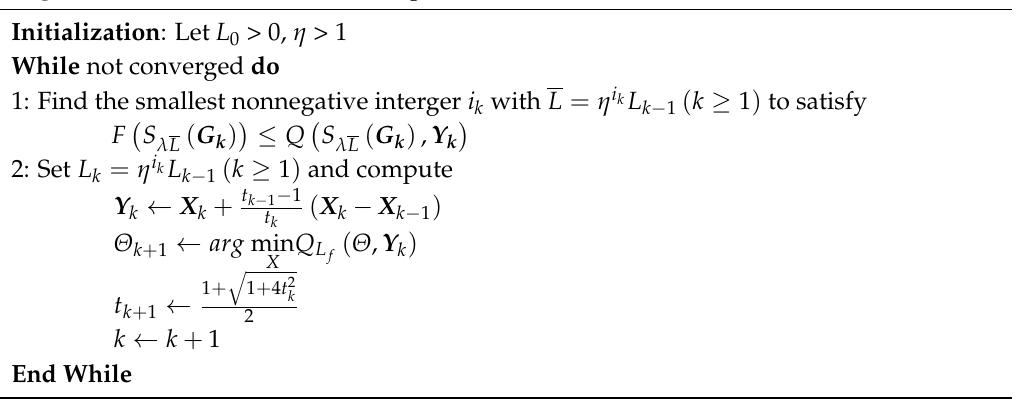
Algorithm 1. APG with backtracking.